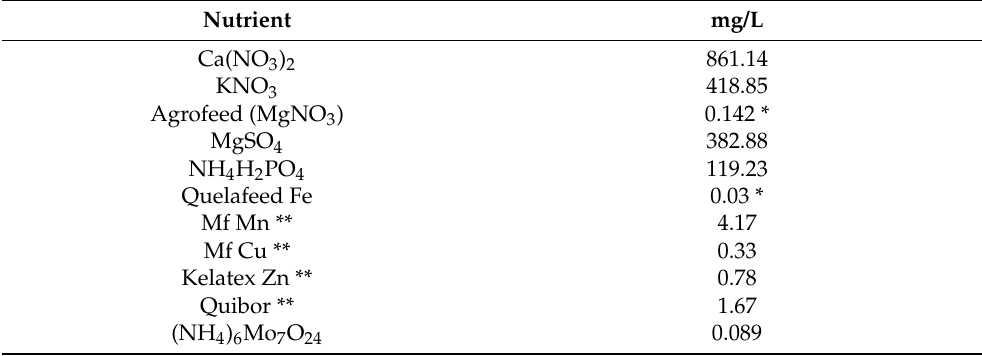
Table A1. Hoagland’s solution used for the fertigation of cape gooseberry plants throughout the growing cycle.